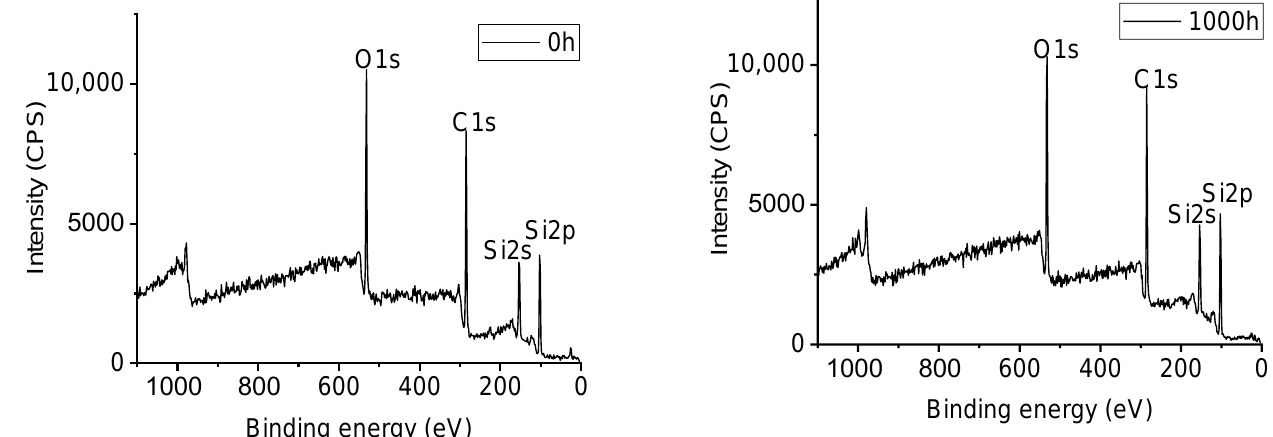
Figure 14. The XPS result of HTV silicone rubber samples.